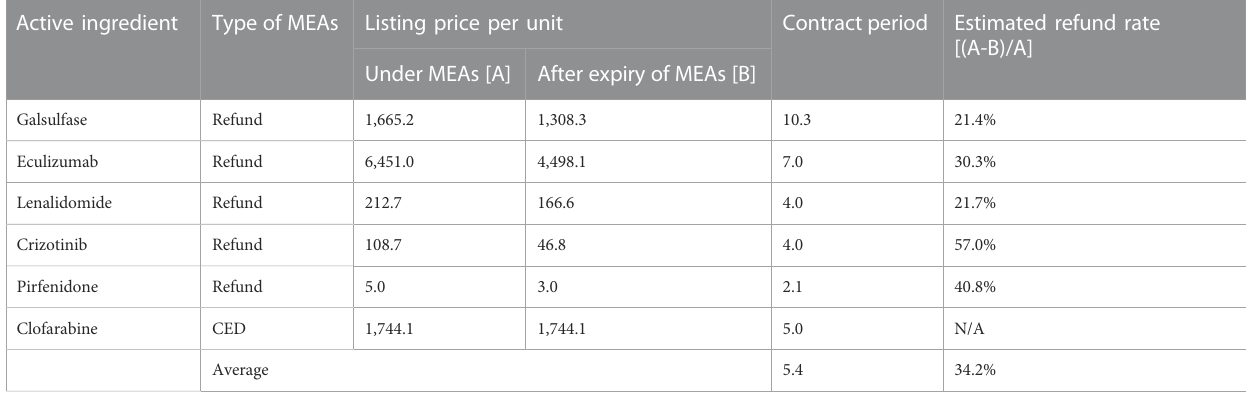
TABLE 2 Listing Price Changes During and After the MEA contracts. Unit: USD, Years. Active ingredient Type of MEAs Listing price per